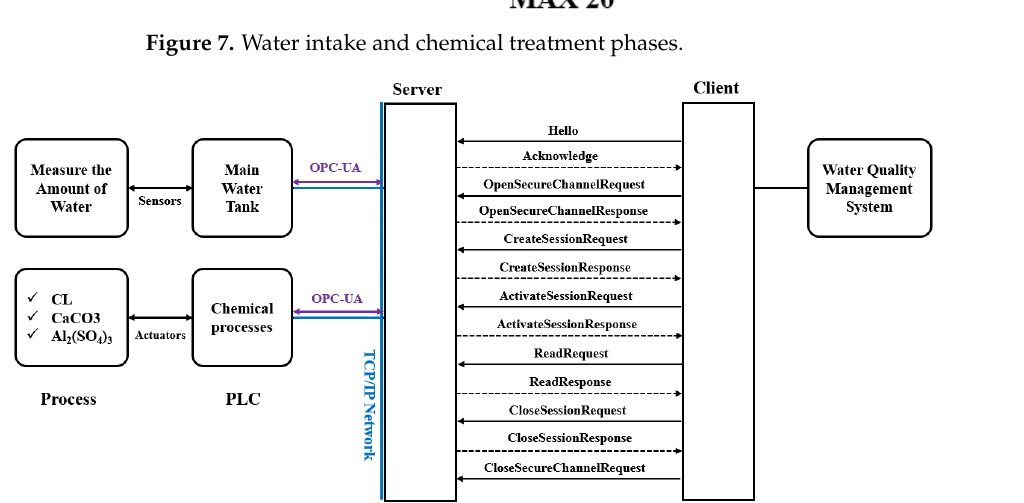
Figure 8. Connection structure between server–client and server–PLC in the scenario.